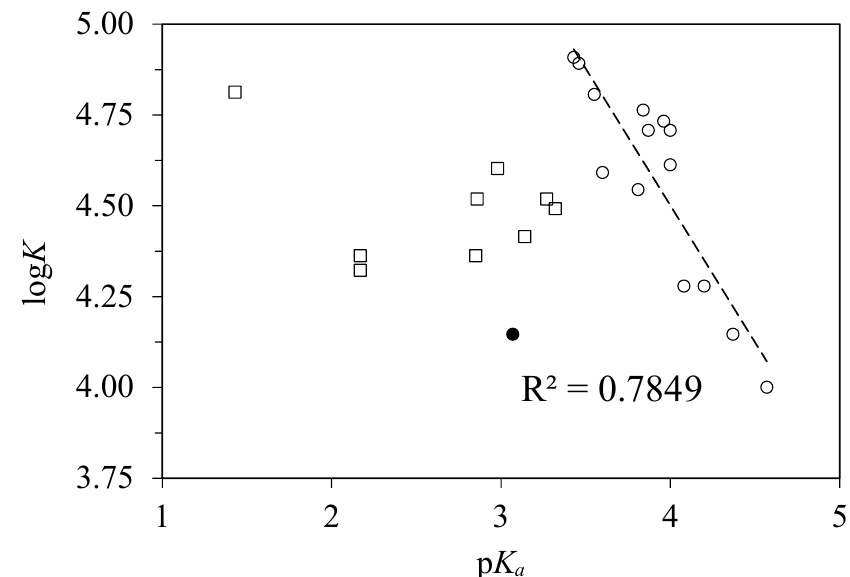
Figure 4. Plot of the logarithms of binding constants log K of substituted benzoic acids to BSA against their p K a values [31]. Empty circles represent m- and p-substituted acids, filled circle represents 3-aminobenzoic acid, empty squares represent o- and o,p-substituted acids.